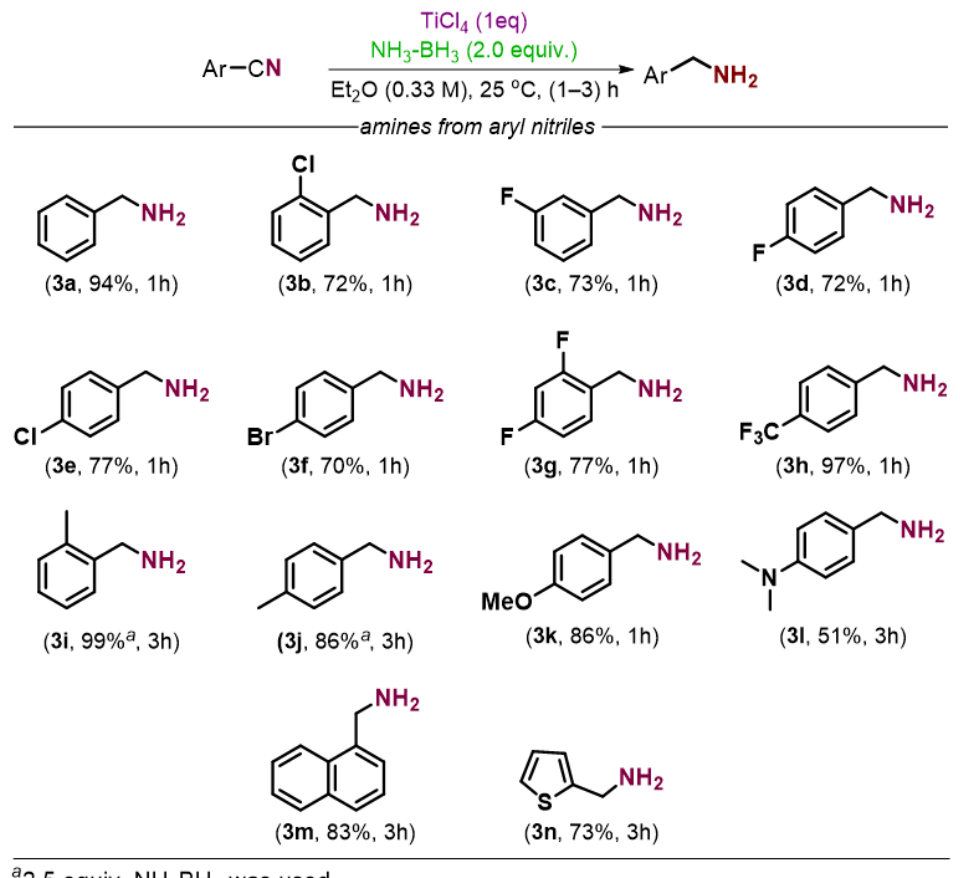
Figure 2. Reduction of activated aromatic nitriles with ammonia borane. Reductions of benzonitrile with an electron-deficient group on the aromatic ring, for example, 4-trifluoromethylbenzonitrile ( 2h ) underwent the reduction efficiently to the corresponding amine 3h in almost quantitative yield 97%, indicating that weak electron- withdrawing groups have no impact on this transformation. The electron-donating 2- and 4- methyl ( 2i – 2j ) did not inhibit the formation of amines ( 3i – 3j ), isolated in 99% and 86% yields in 3 h, respectively, although a slightly higher molar equivalent of 1a (2.5 equiv.) was necessary for complete reduction. Furthermore, the reaction of increased electron- donating 4-methoxybenzonitrile was converted to the desired product methanamine 3k in good yield (86%). It should be noted that higher temperatures were required when diisopropylaminoborane reagent was used for reduction of 2k [35]. However, para - N , N - dimethylaminobenzonitrile ( 2l ) provided the corresponding aminobenzylamine ( 3l ), al- beit in diminished yield (51%) even when the reaction was extended to 24 h. The sluggish reactivity was attributed to the deleterious effect of the dimethylamino group, which might be exchanging borane with ammonia and rendering the reduction ineffective or due to the deactivation of the catalyst by complexation with the non-bonding electrons on nitrogen. As a representative of a bulky aryl nitrile, 1-cyanonaphthalene ( 2m ) was subjected to the new ammonia borane reduction under the optimized conditions when the